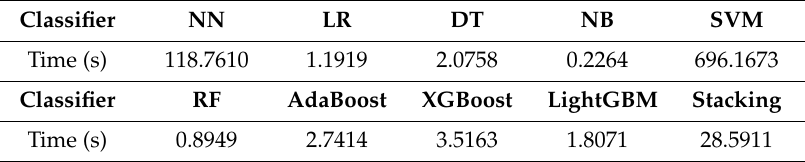
Table 3. Operating time across di ff erent classifiers (unit: